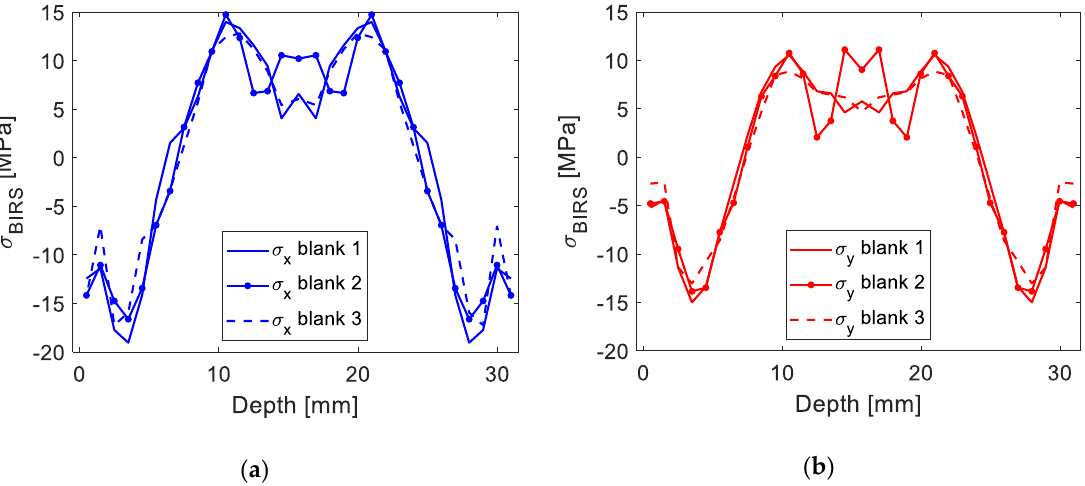
Figure 12. Measured BIRS profile in three Al7050-T7451 machining blanks considering BIRS, χ 0 , and MIRS: In X direction ( a ), and in Y direction ( b ).